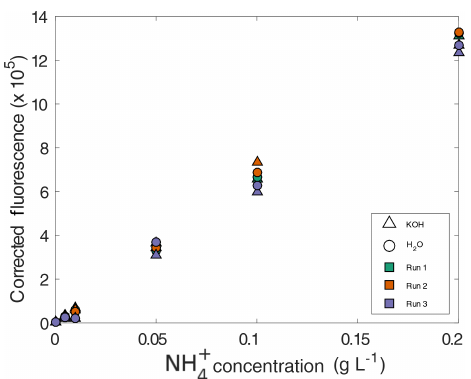
Figure 5. Digestion length test for BCR-2 by the fluorometry tech- nique. Samples were digested in 2mL 50% HF for the number of days indicated. Analyses reproduce published value (34ppm, black line) within error after only 2 days and, aside from one analysis 8 days after digestion began, approximate this value afterwards. There is large error in some samples compared to Table 3, likely due to the increased number of analyses reported in Table 3, de- creasing standard deviation.